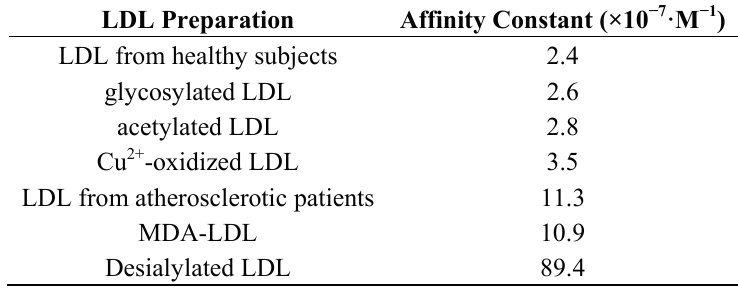
Table 1. Affinity constants of anti-low-density lipoproteins (LDL) (×10 − 7 · М − 1 ). Adapted with permission from [166]. (1991) (Orekhov, A.N.; Tertov, V.V.; Kabakov,